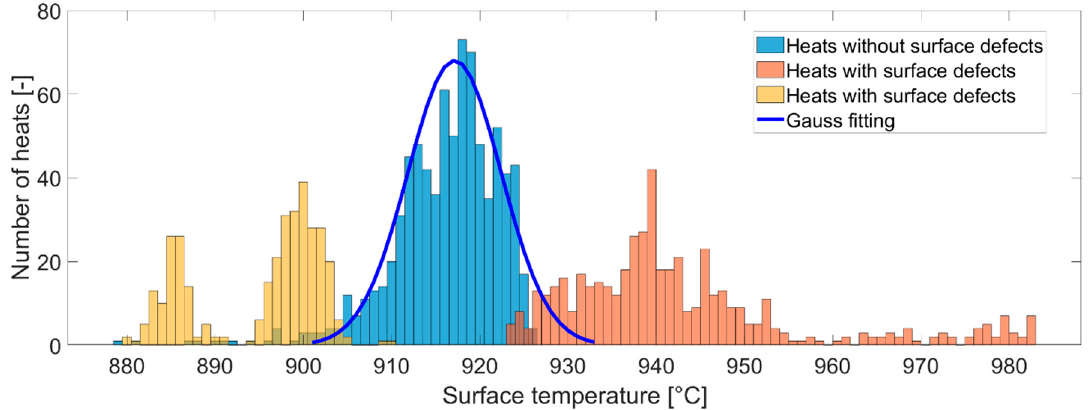
Figure 5. Surface temperatures in unbending point with and without defects.